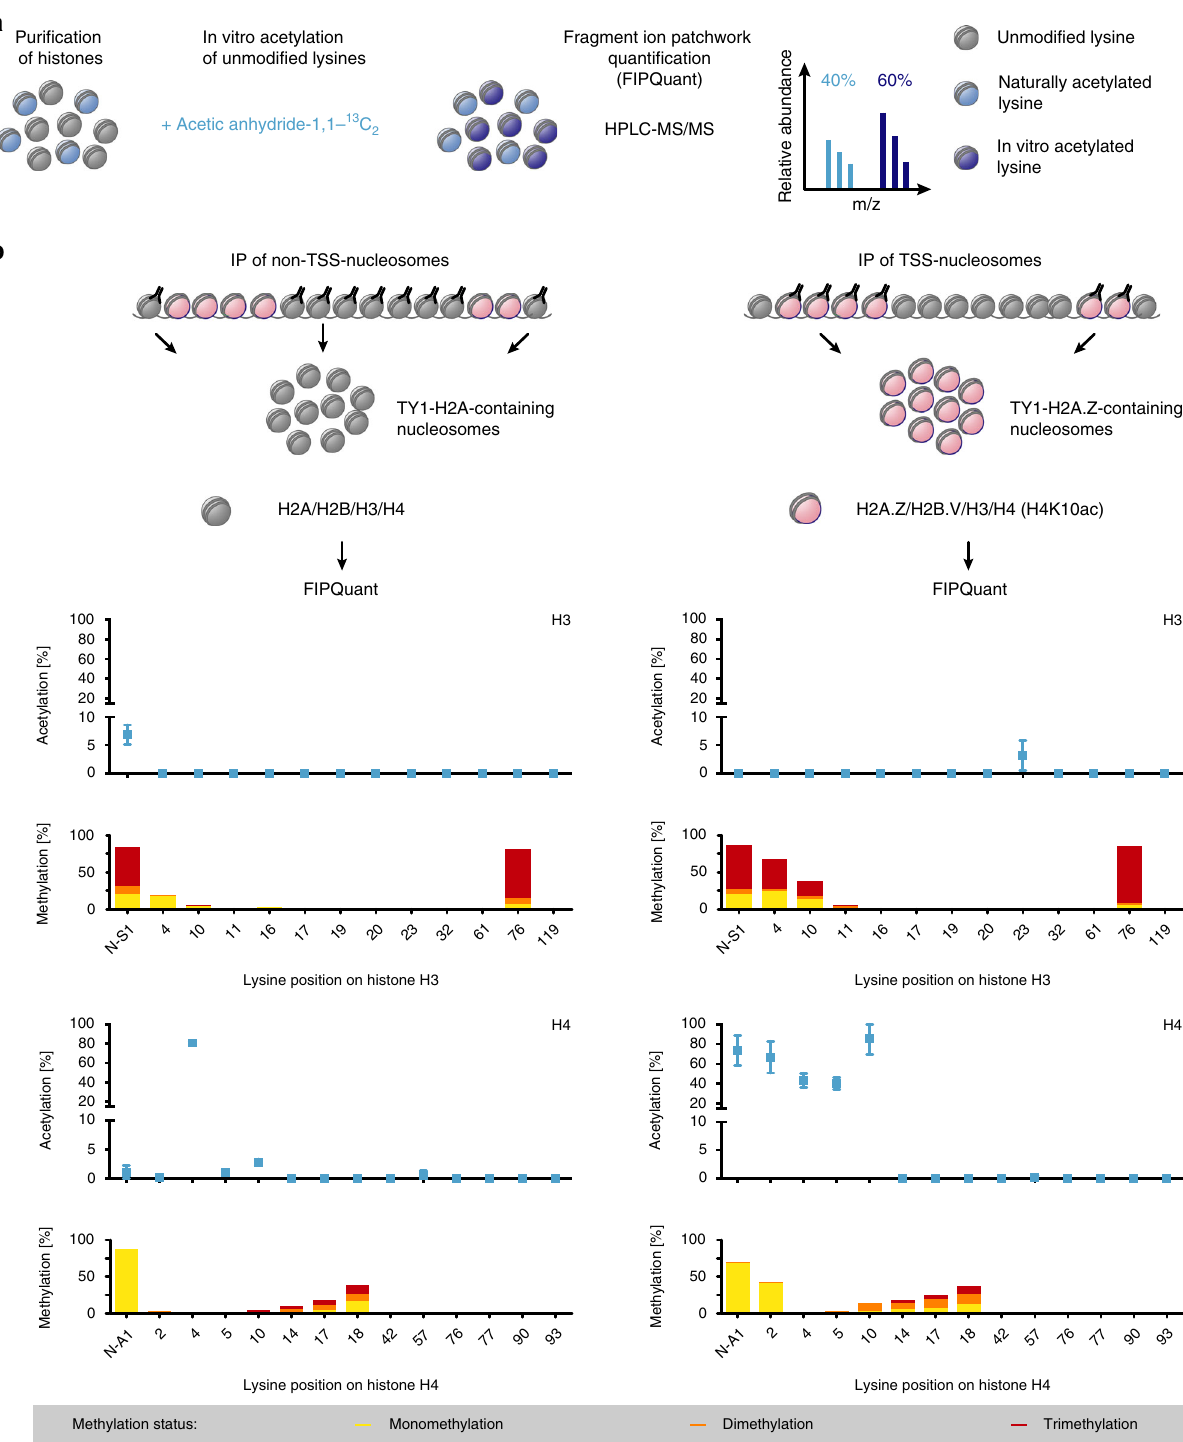
Fig. 2 Identi fi cation of acetyl and methyl marks enriched at TSSs. a Outline of the Fragment Ion Patchwork Quanti fi cation (FIPQuant) methodology. Following histone puri fi cation, unmodi fi ed lysines were in vitro labeled with a C 13 -acetyl mark and analyzed by mass spectrometry. The levels of site- speci fi c lysine acetylation were determined using FIPQuant. b PTM-patterns of H3 and H4 from non-TSS- and TSS-nucleosomes. TSS- and non-TSS- nucleosomes were enriched by immunoprecipitation of TY1-H2A.Z and TY1-H2A-containing nucleosomes, respectively. The acetylation percentages [%] (blue) represent the averages of the median values from each of the independent experiments (left panel n = 3, right panel n = 7) determined by FIPQuant. Error bars indicate standard deviations. Lysine-speci fi c mono- (yellow), di- (orange) and/or trimethylation (red) levels are shown for H3 and H4 from non- TSS- (left panel; n = 3) and TSS-nucleosomes (right panel; n = 7) and are plotted as stacked bars representing the averages of the estimated methylation percentages based on identi fi ed mono-, di- and trimethylated spectra. Supplementary Fig. 4 shows the data of each replicate. Source data are provided as a Source Data fi